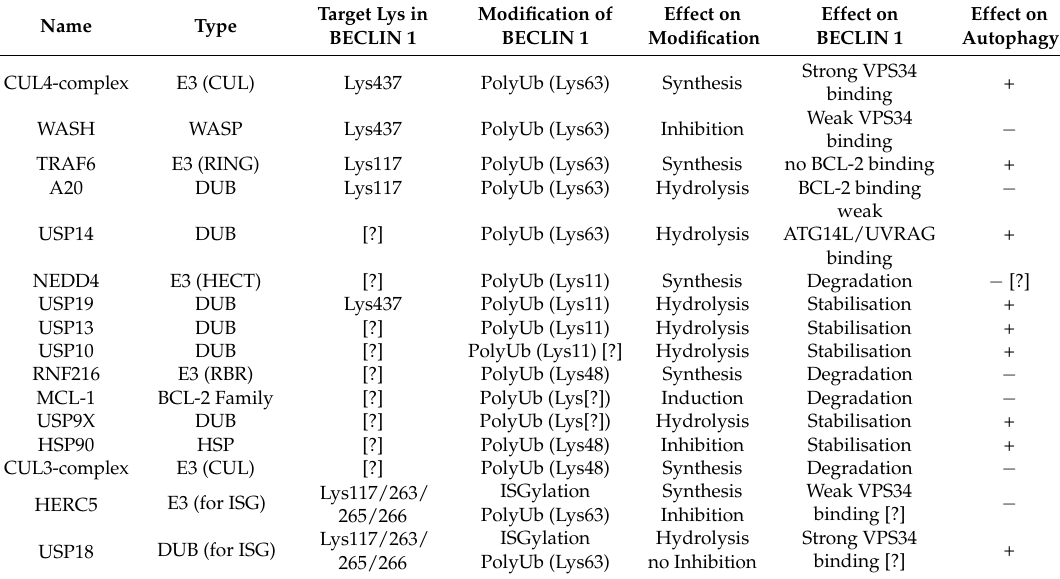
Table 1. Factors involved in the regulation of BECLIN 1 by ubiquitin and the ubiquitin-like ISG15. The corresponding stimulating (+) or inhibiting ( − ) effect on autophagy is listed. Information that is not known or that has not directly been investigated is marked with a [?]. We refer to the text for more detailed information about the factors listed in this summary